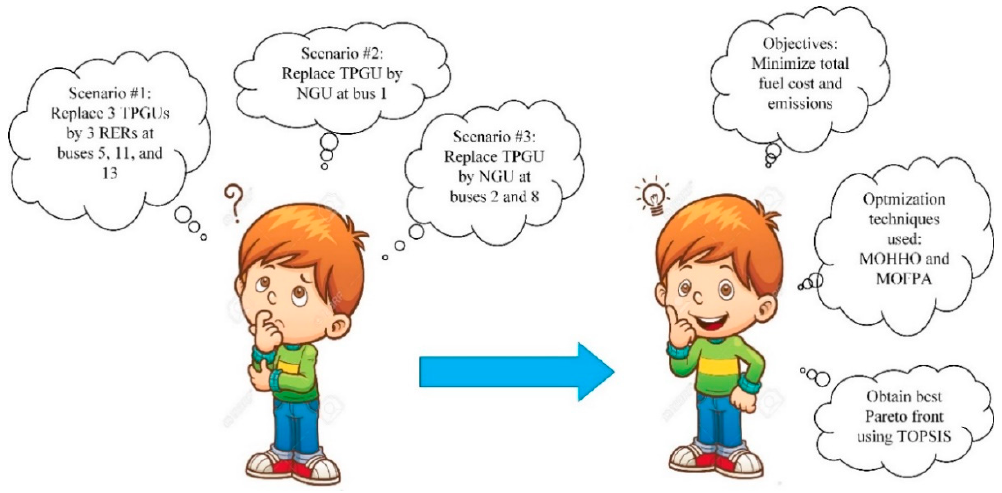
Figure 2. The procedure of the proposed techniques.